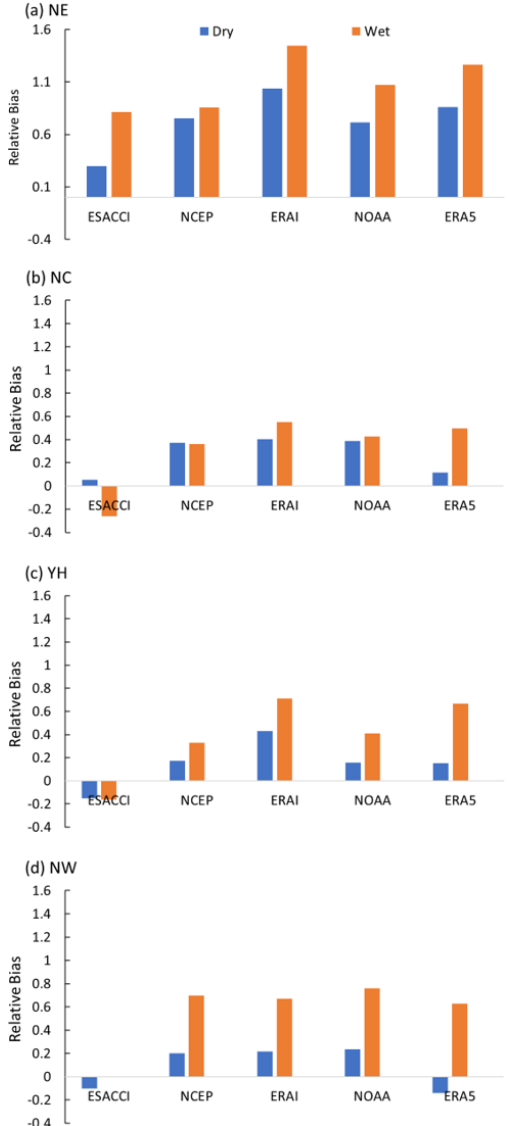
Figure 10. The rBias of remote sensing and reanalysis SM against in situ observations under dry or wet conditions. The dry condition consists of extreme (scPDSI < − 4) and severe (scPDSI < − 3) drought conditions; the wet condition consists of ex- treme (scPDSI > 4) and severe (scPDSI > 3) wet spell conditions.